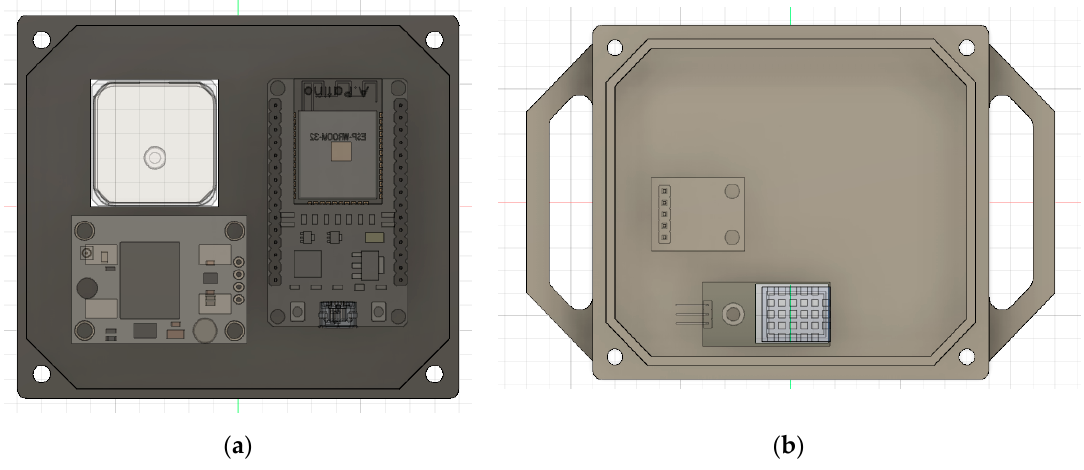
Figure 8. Upper side ( a ) and bottom side ( b ) of the cover box.